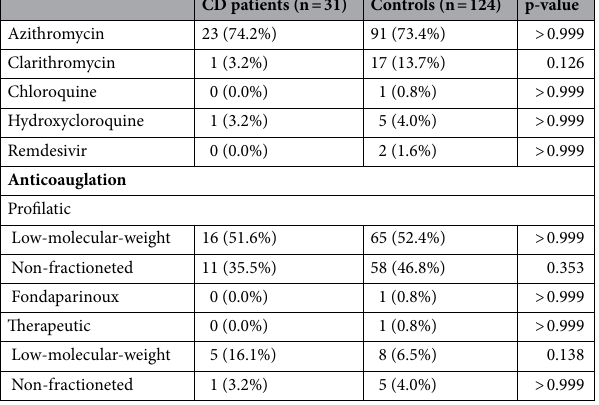
CD patients (n = 31) Controls (n = 124)